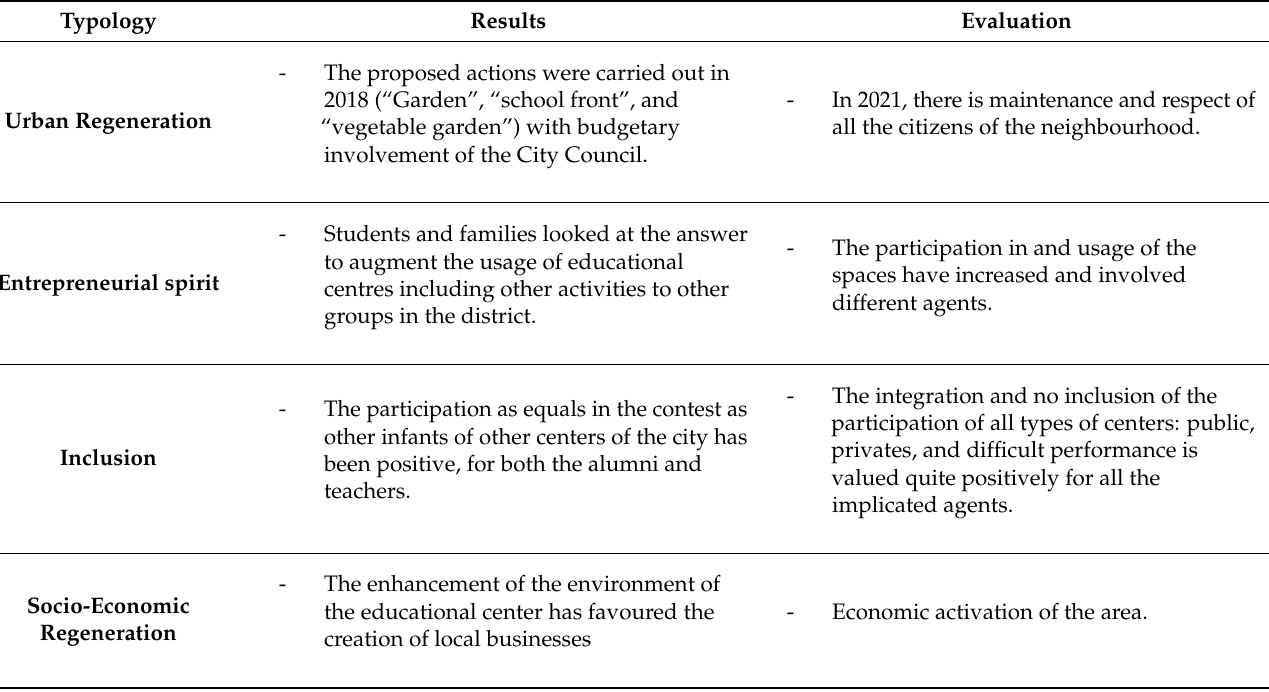
Table 6. Results of the students’ work “Everyone’s Responsibility: Pet Spreading” by Pio XII Primary